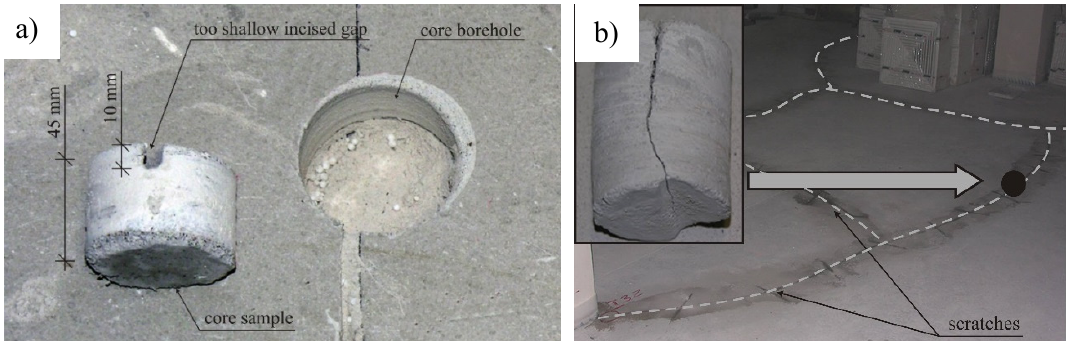
Figure 11. An exemplary view: ( a ) of a core borehole made in the floor, and also a core sample showing an expansion joint that is cut too shallow and ( b ) cracks on the surface of floors, along with an approximation of the cut core sample documenting the depth of one of the cracks.